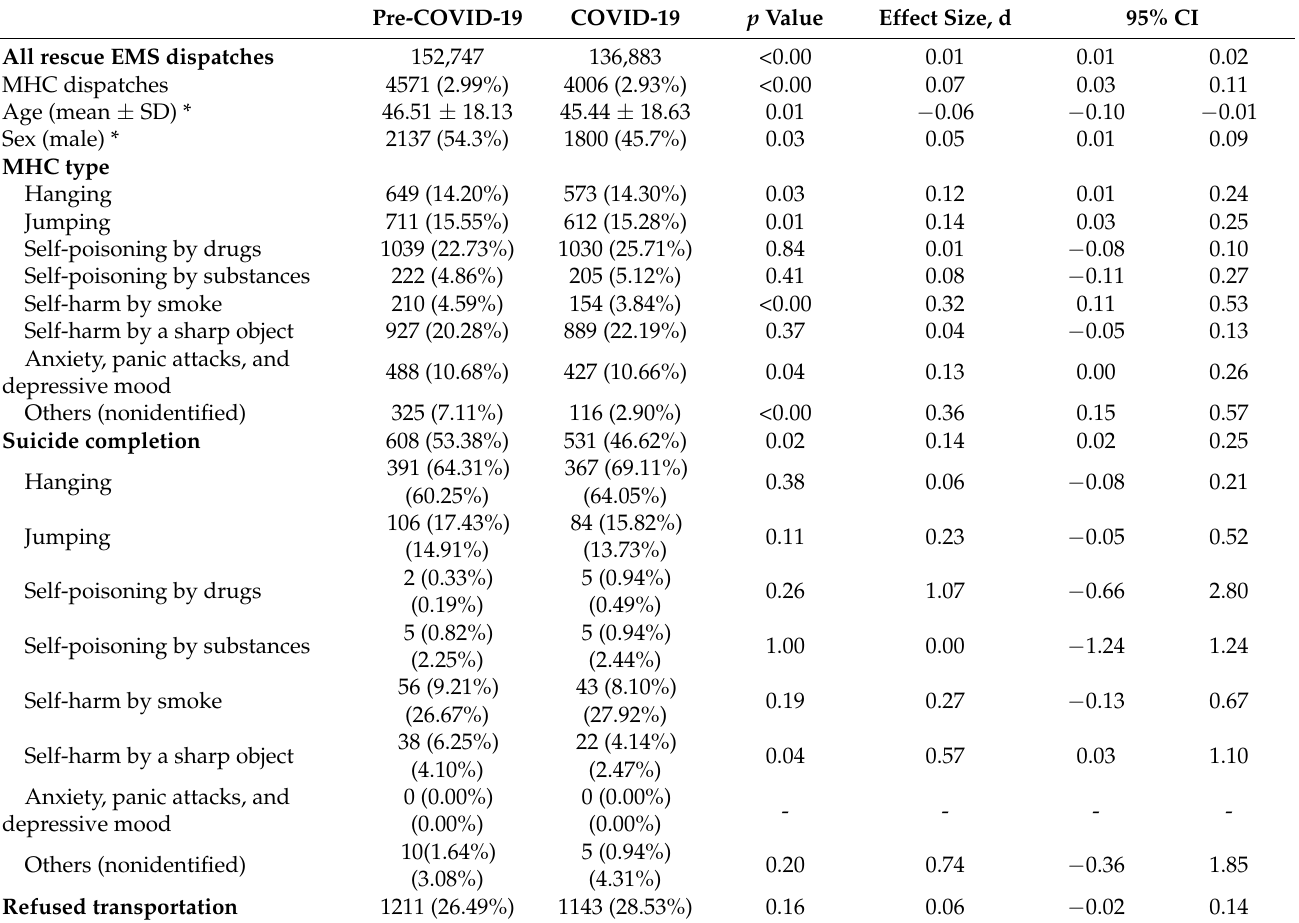
Table 2. Comparison of the types of patients experiencing MHCs who used EMSs before and during the COVID-19 pandemic.